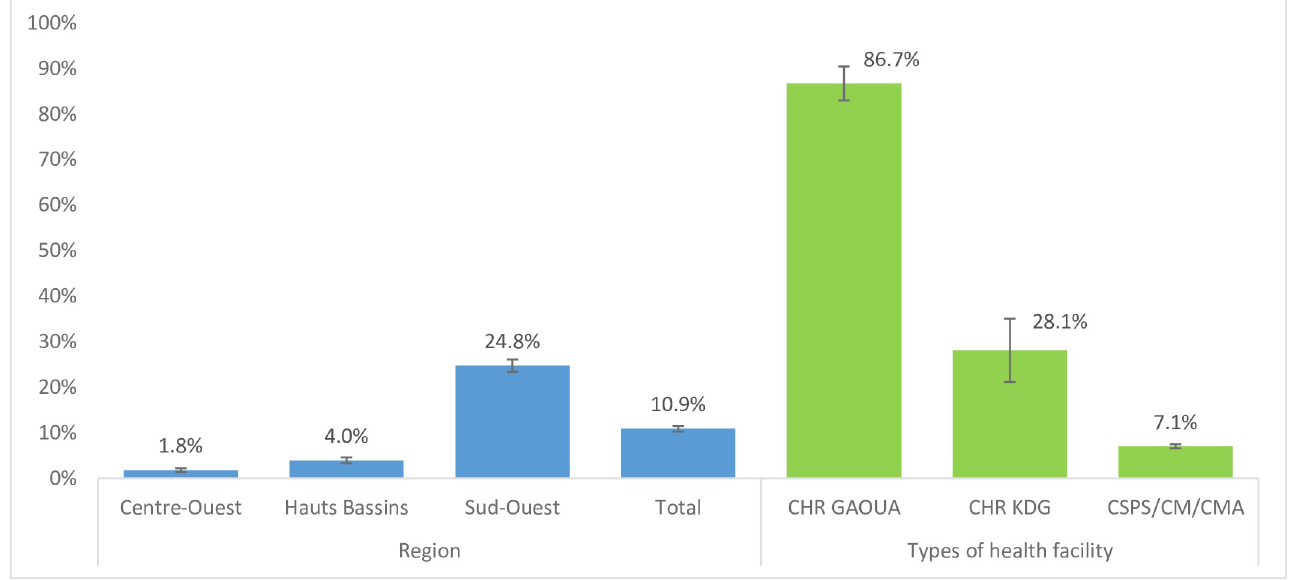
Fig 3. Percentage of hospitalised snakebite patients that received antivenom treatment—by region (blue bars) and facility type (green bars).